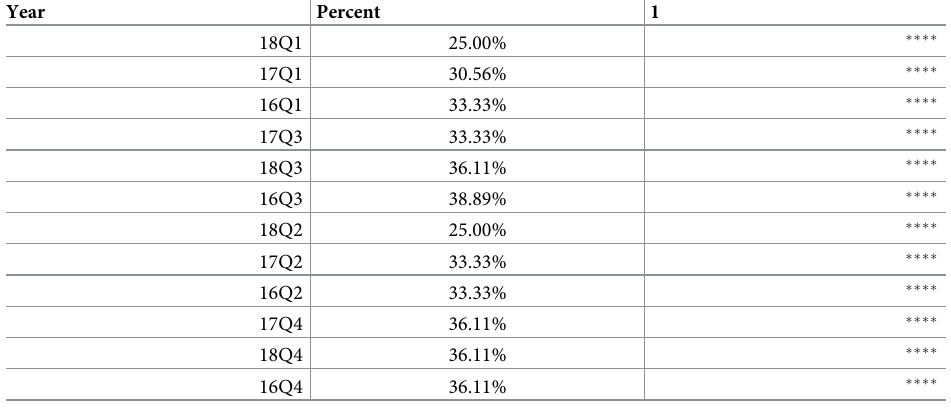
Note: ���� —homogeneous groups (p >